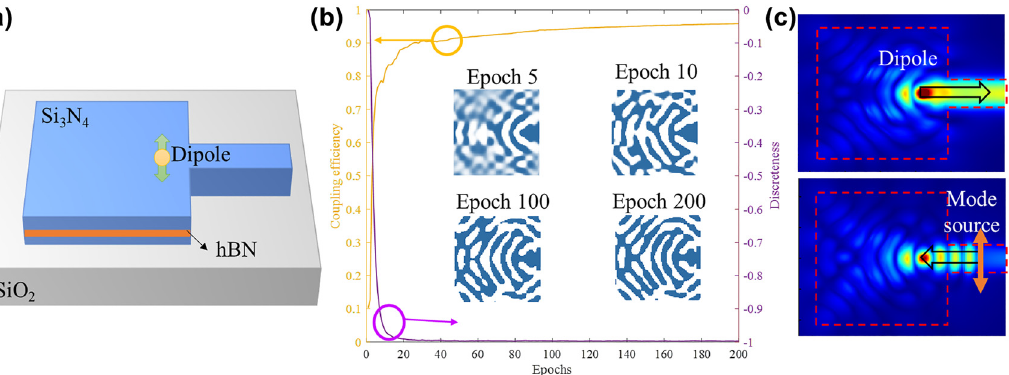
N -hBN hybrid cavity on a SiO substrate [39], where 3 4 2